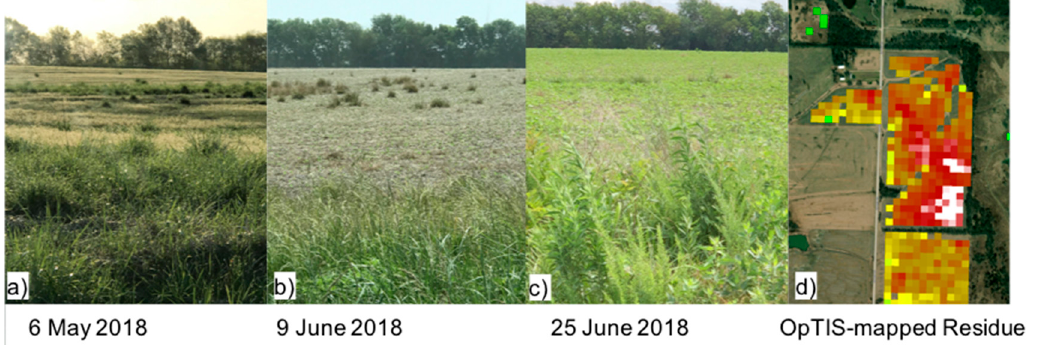
Figure 6. Roadside photos of field ID 86–1751 in Missouri observed from ( a ) May 6, 2018, ( b ) June 9